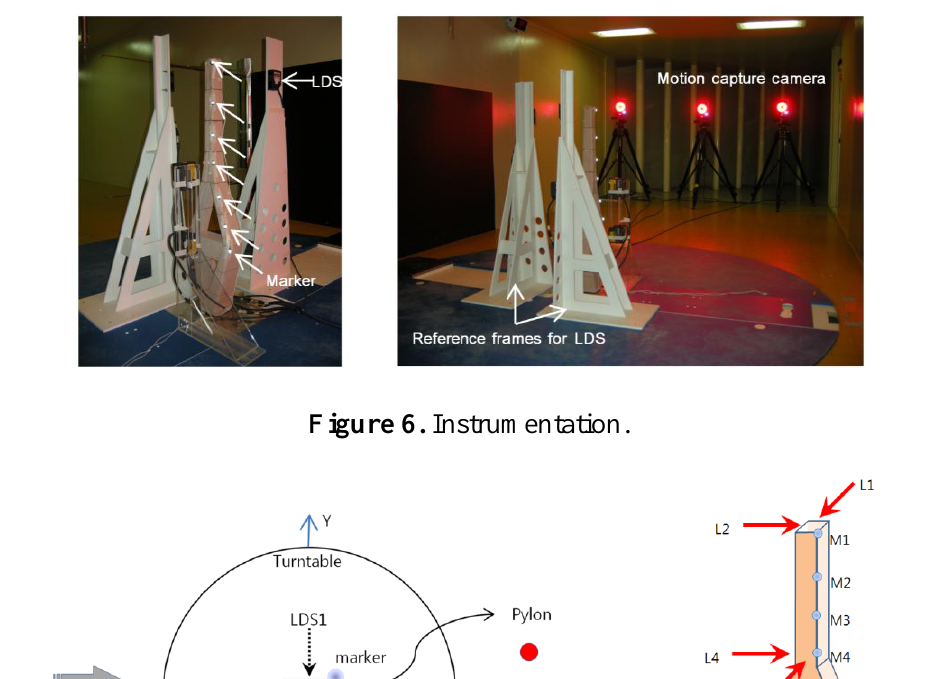
Figure 5. Specimen setup.